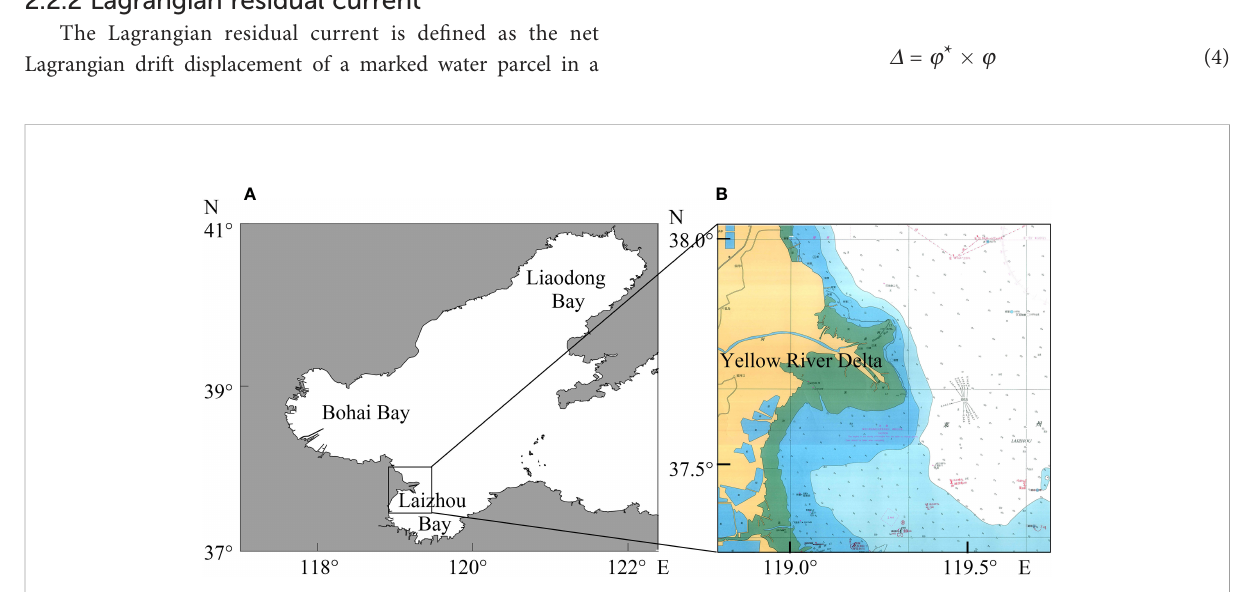
FIGURE 2 The topographic map of Bohai (A) and water depth in the main study area of Yellow River Delta (B)